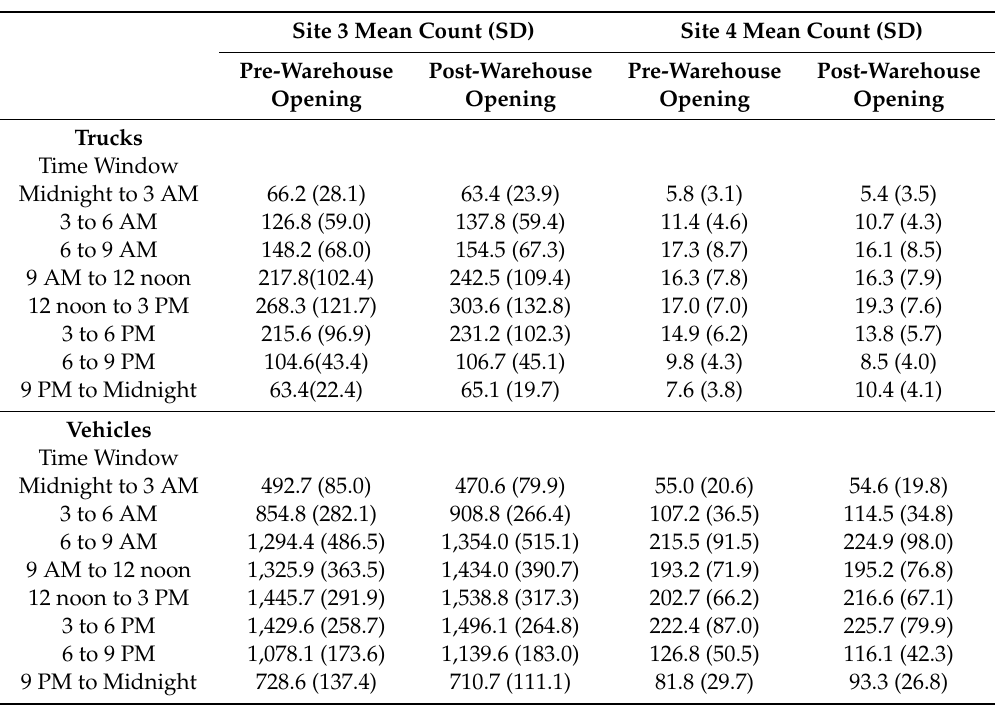
Table 3. Descriptive statistics for measured truck and vehicle counts before and after the opening of an online grocery delivery service warehouse in a South Bronx